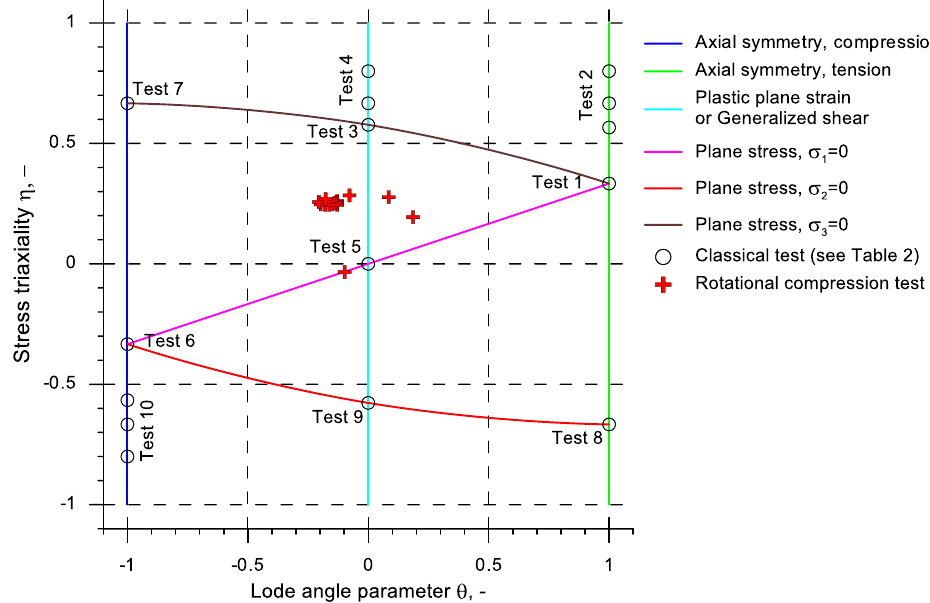
Figure 16. Representation of the state of stress on the surface η and θ with the tests used to calibrate the damage function. Materials 2019 , 13 , x FOR PEER REVIEW